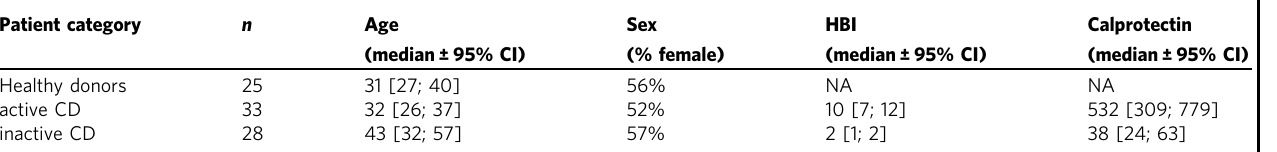
Table 1 CD patients and Healthy donor